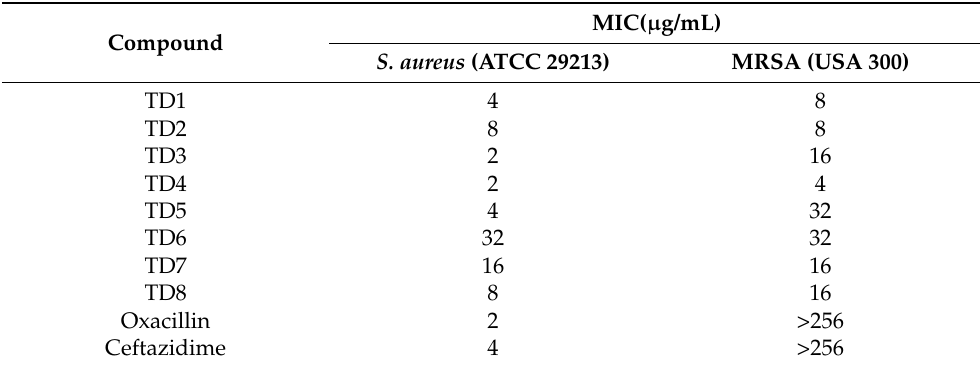
Table 1. Antibacterial activity of thiourea derivatives.